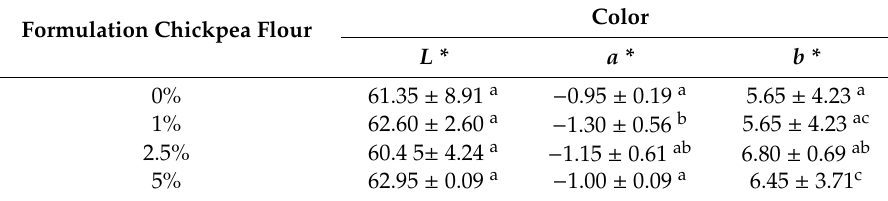
Table 2. Color of probiotic yogurt fortified with chickpea flour during first week of storage at 4 ◦ C ( n = 3, mean ± SD).